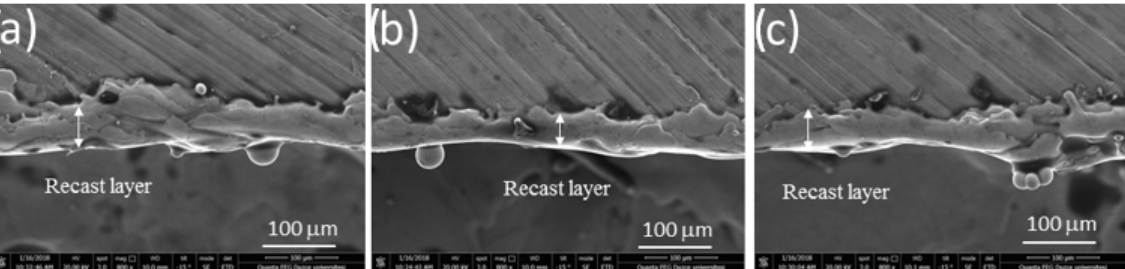
Figure 9. Cross-section views of samples: ( a ) UT (1-7), ( b ) SCT (2-7) and ( c ) DCT (3-7).